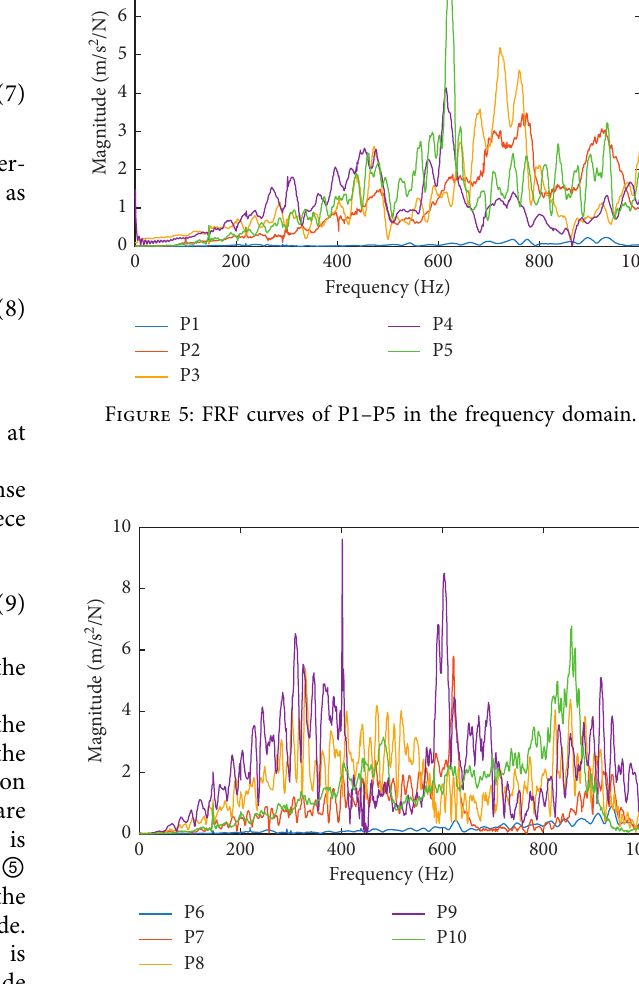
Figure 6: FRF curves of P6–P10 in the frequency domain.